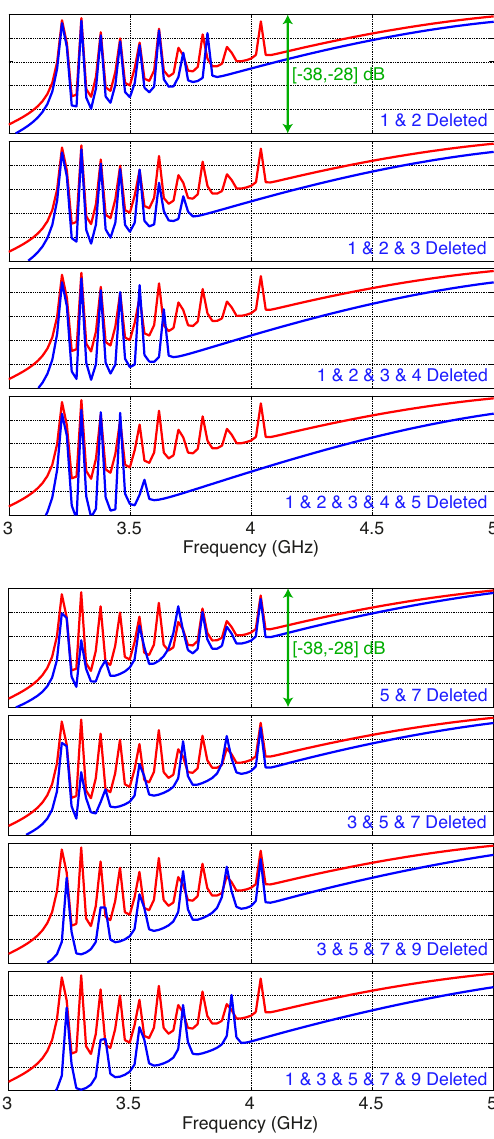
Figure 5: Electromagnetic responses of RFID tags that are obtained by deleting bits consecutively from the overall structure in Fig. 1.